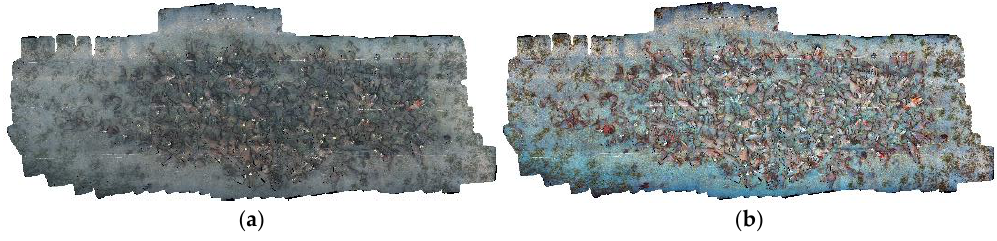
Figure 9. Textured 3D models based on MazotosA dataset and created with two different strategies. ( a ) 3D model created by means of only LAB enhanced imagery both for the 3D reconstruction and texture. ( b ) 3D model created following the methodology suggested above: the 3D reconstruction was performed using the LAB enhanced imagery and the texturing using the more faithful to the reality ACE imagery.